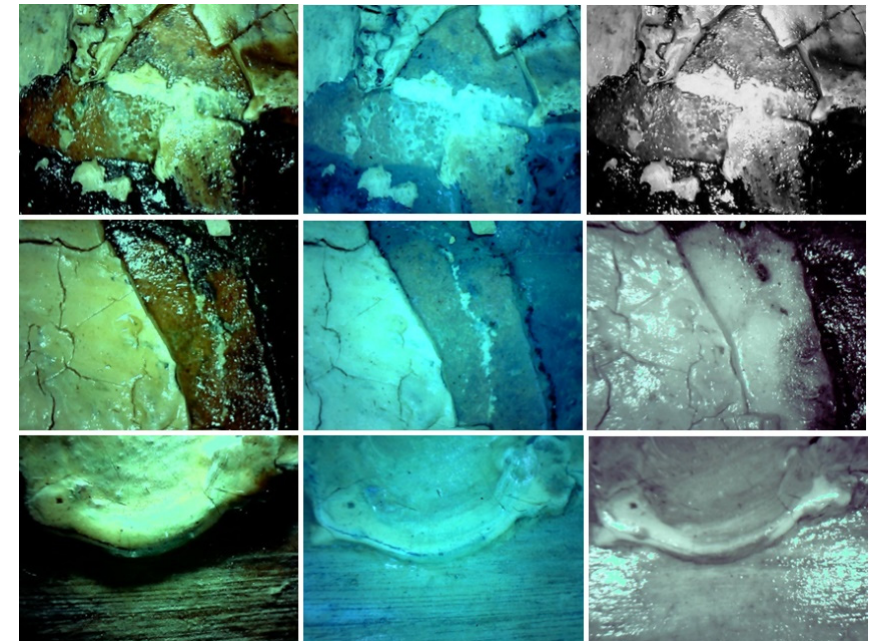
Figure 12. Images of areas with ageing cracks and other superficial deteriorations of the pictorial layers, analyzed in the three reflected lights: white-green (550 nm), UV (365 nm), and IR (850 nm), using Forensic magnifier at 30×.